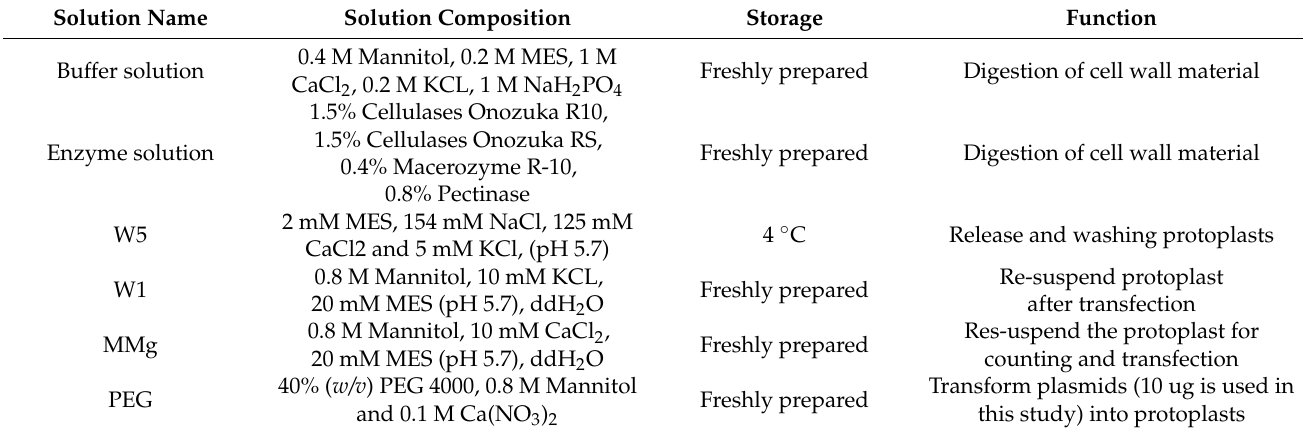
Table 1. Solution recipes for protoplast isolation and